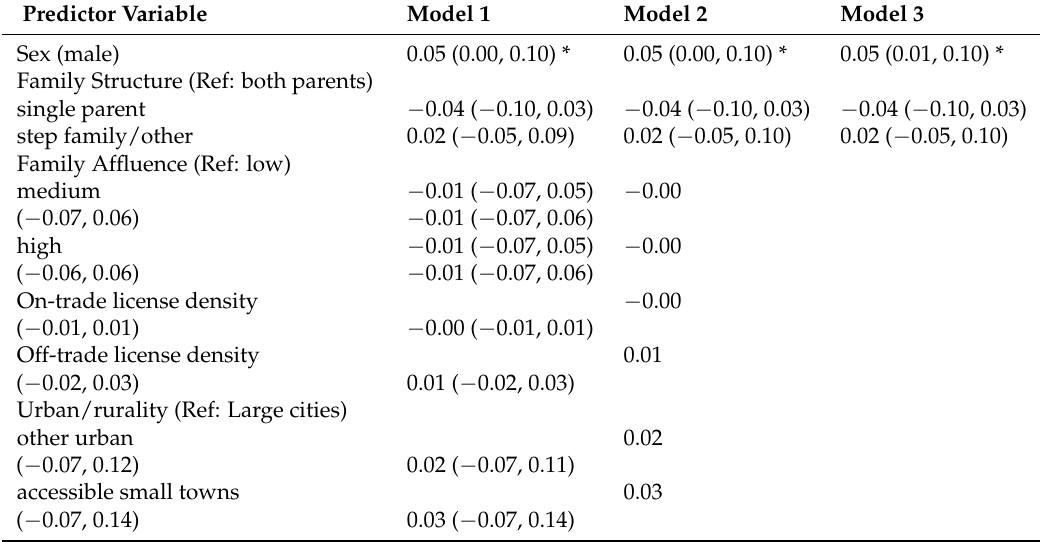
Table A4. Conformity motives regressed on neighborhood and individual measures (95% credible intervals) n = 1048 (Intermediate Data Zones n =